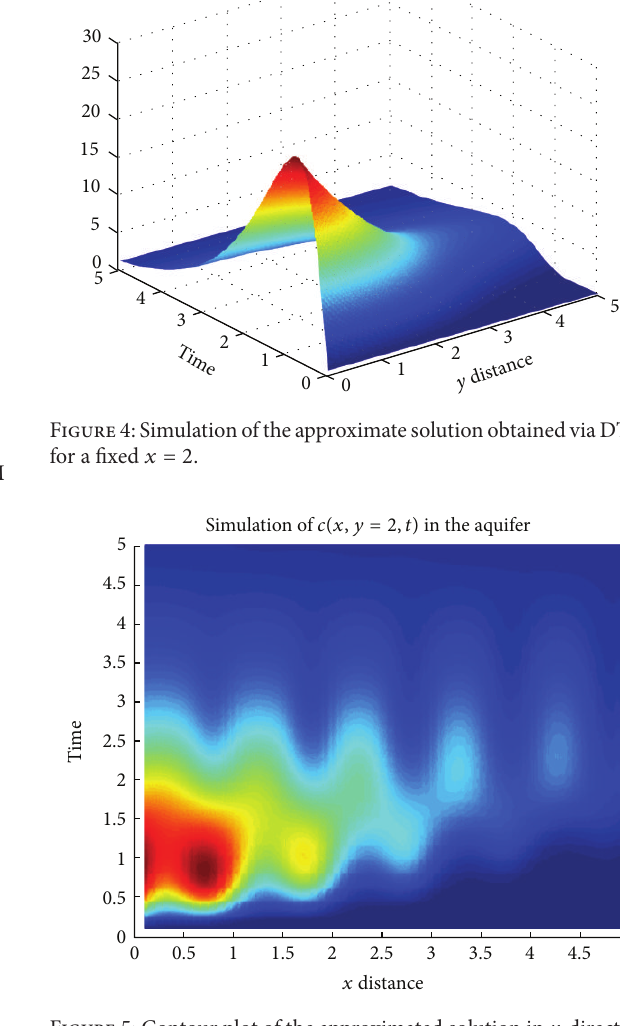
Figure 5: Contour plot of the approximated solution in x -direction for fixed 𝑦